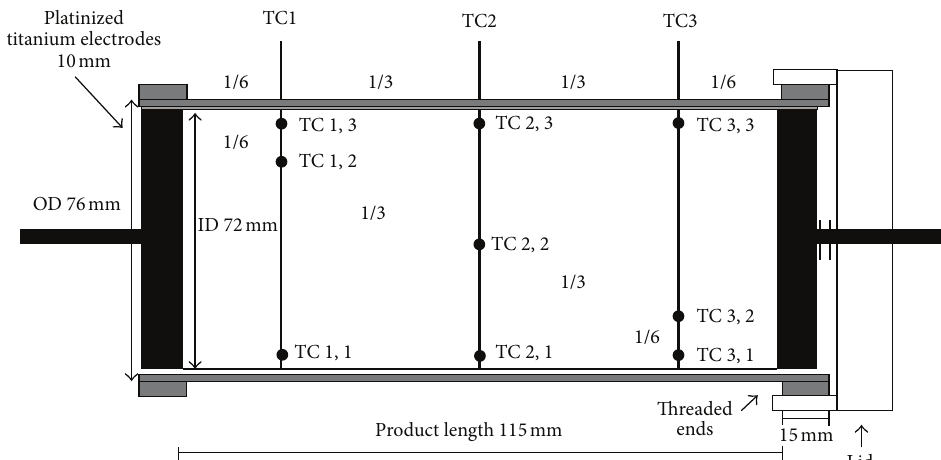
Figure 2: Sketch of OH cell used in the experimental validation of the model, including 9 thermoprobes’ positions [10].